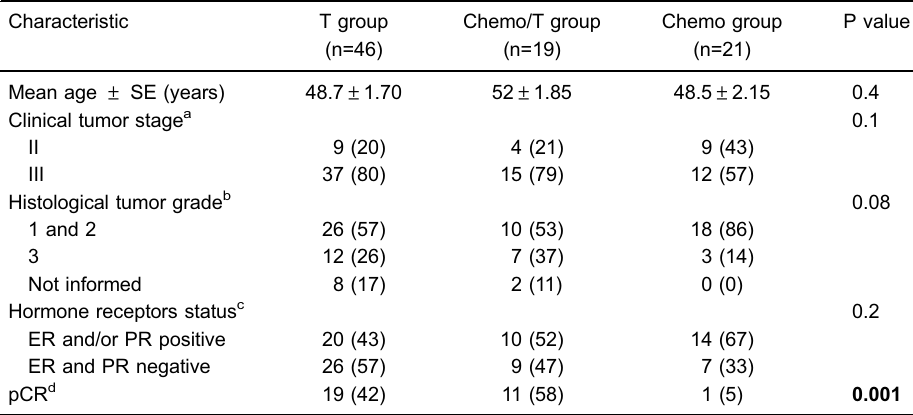
Table 1. Characteristics of the 86 patients with HER2-positive breast cancer treated with neoadjuvant chemotherapy with or without trastuzumab (T) from 2008 to 2013.